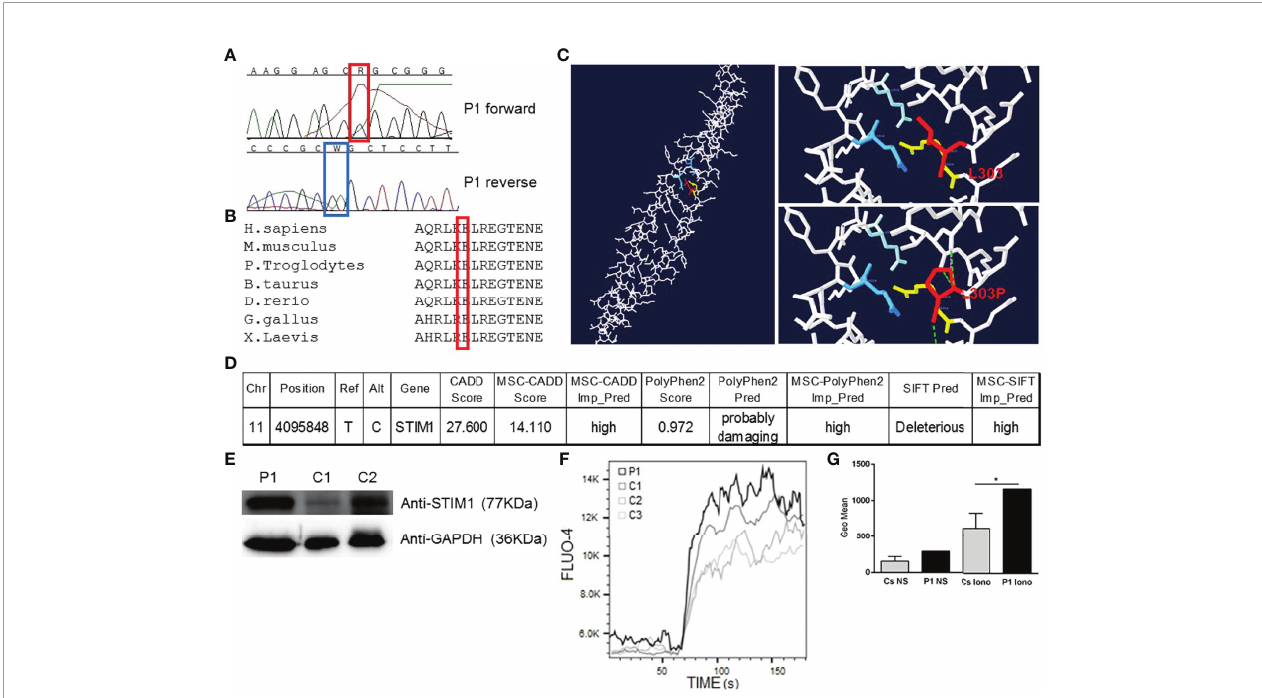
FIGURE 1 | Heterozygous STIM1 mutation in a patient with myopathy. (A) The sequence of the PCR products of genomic DNA from the patient ’ s leukocytes is shown. g.4095848T>C (c.1477T>C, p.L303P). This mutation has not been previously reported. (B) Multiple alignment of the sequences from humans and 6 other species, showing that L303 is a conserved amino acid in 7 analysed species. (C) The left panel shows the structure of human CC1-IH STIM1 (4). The top right panel shows the interactions between 2 alpha helices of the CC1-IH region of STIM1. Blue is Q314 and light blue is E318 of one alpha helix, and L303 and R304 are the red and yellow residues, respectively, of the other alpha helix (4). The bottom right panel shows the L303P mutation. The fi gure was produced using Swiss- PdbViewer. (D) Mutation signi fi cance cut-off (http://pec630.rockefeller.edu:8080/MSC/) of STIM1 L303P mutation. (E) Immunoblot analysis of STIM1 protein from the patient ’ s (P1) peripheral blood mononuclear cells (PBMCs) and from 2 healthy donors (C1 and C2). We employed GAPDH as a loading control. The panels illustrate the results from a single experiment, representative of 3. (F) Calcium fl ux analysis in the PBMCs of P1 and 3 healthy donors (C1, C2, and C3) in response to ionomycin. The panels illustrate the results from a single experiment, representative of 3. (G) Calcium fl ux geometric mean (Geo Mean) is represented for C1, C2, and C3. ± SD and P1 in non-stimulated PBMCs (NS) or ionomycin-stimulated PBMCs (Iono). p <0.05